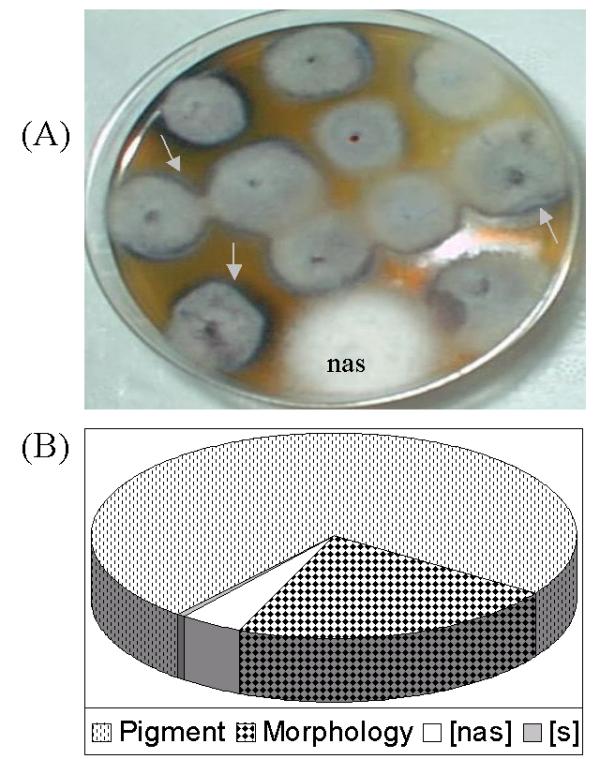
Phenotypic characterization of transformants. (A) Detection of a nas mutant phenotype among 12 transformants. Arrows indicate some Secteurs. (B) Summary of the different mutants recovered among the 5000 transformants: 152 were altered in pigmentation (99 reddish, 16 white/beige/yellow, 37 greenish), 45 were altered in colony morphology (12 irregular, 12 compact, 19 colonial, 2 fluffy), and 10 were affected in the expression of the Secteur (9 nas and 1 s).